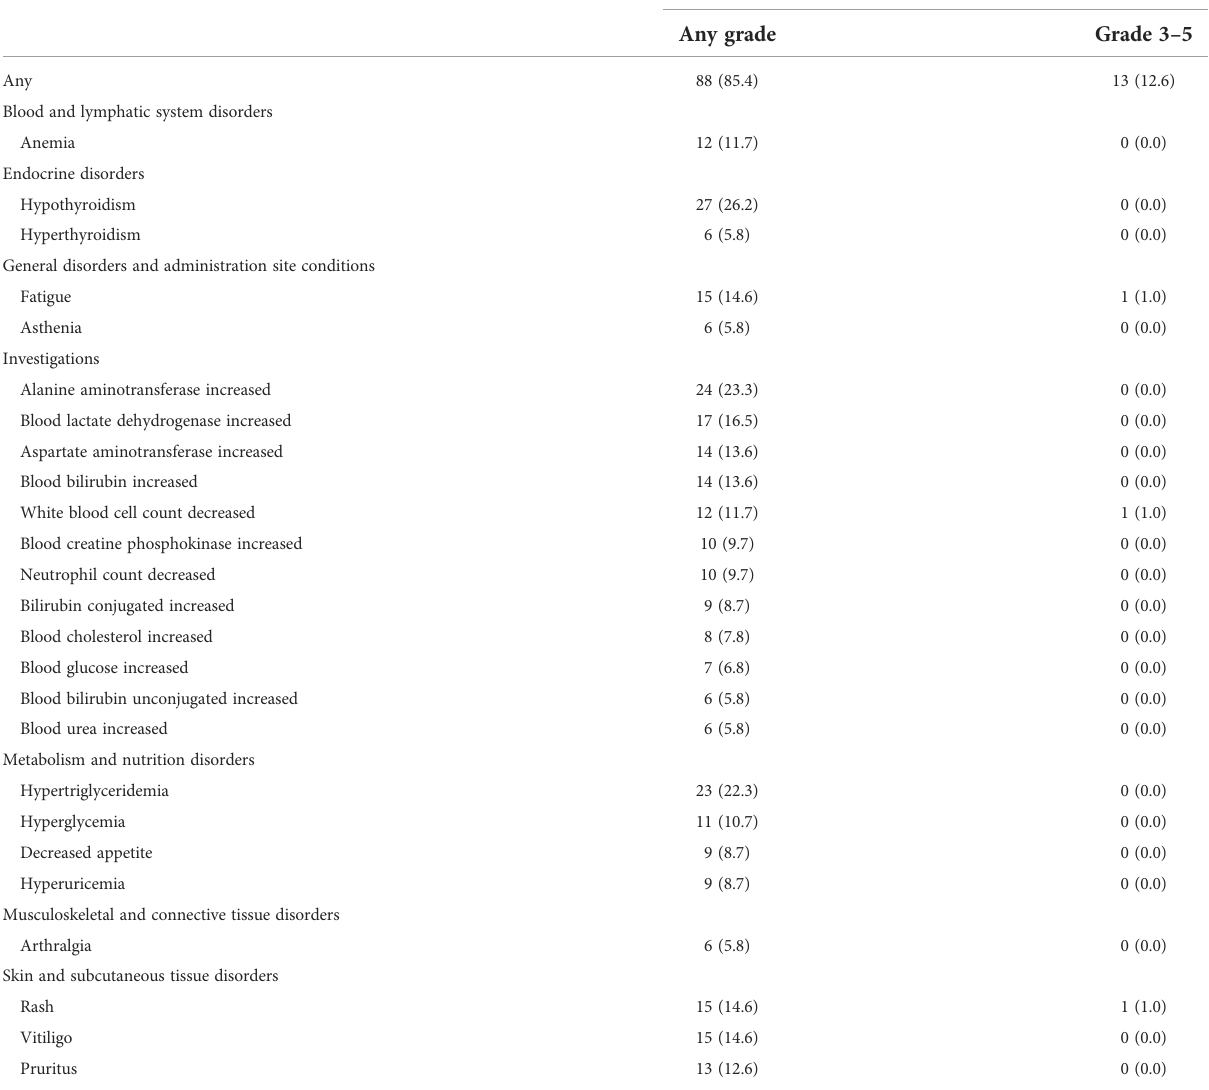
TABLE 1 TRAEs occurring in ≥ 5% of patients (ASaT